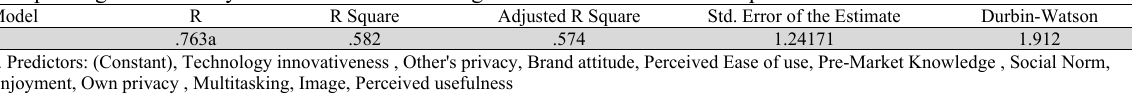
Table 5 Multiple Regression Analysis of Social & Technological Factors with ARSG adoption Model R R Square